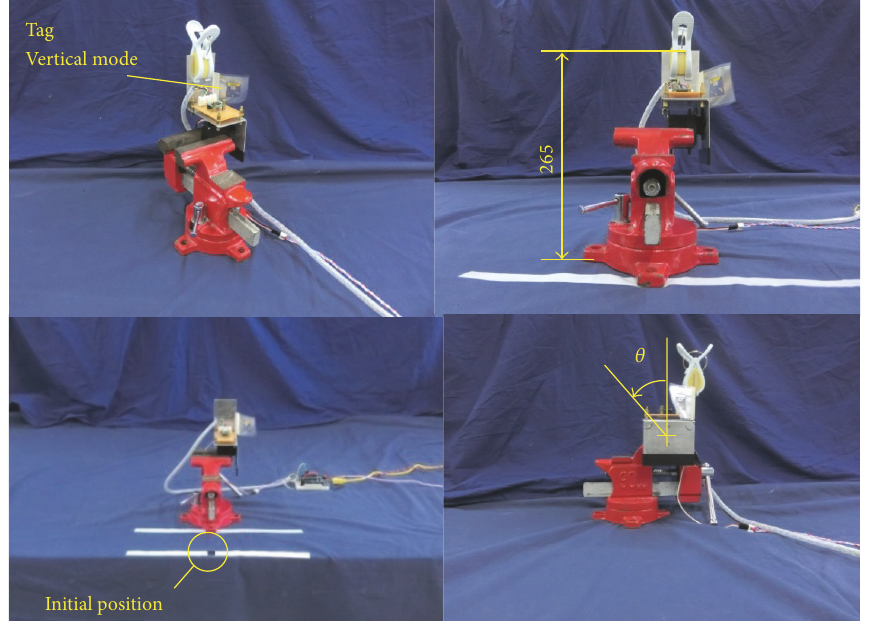
Figure 10: Experimental equipment of Random Angle Test.